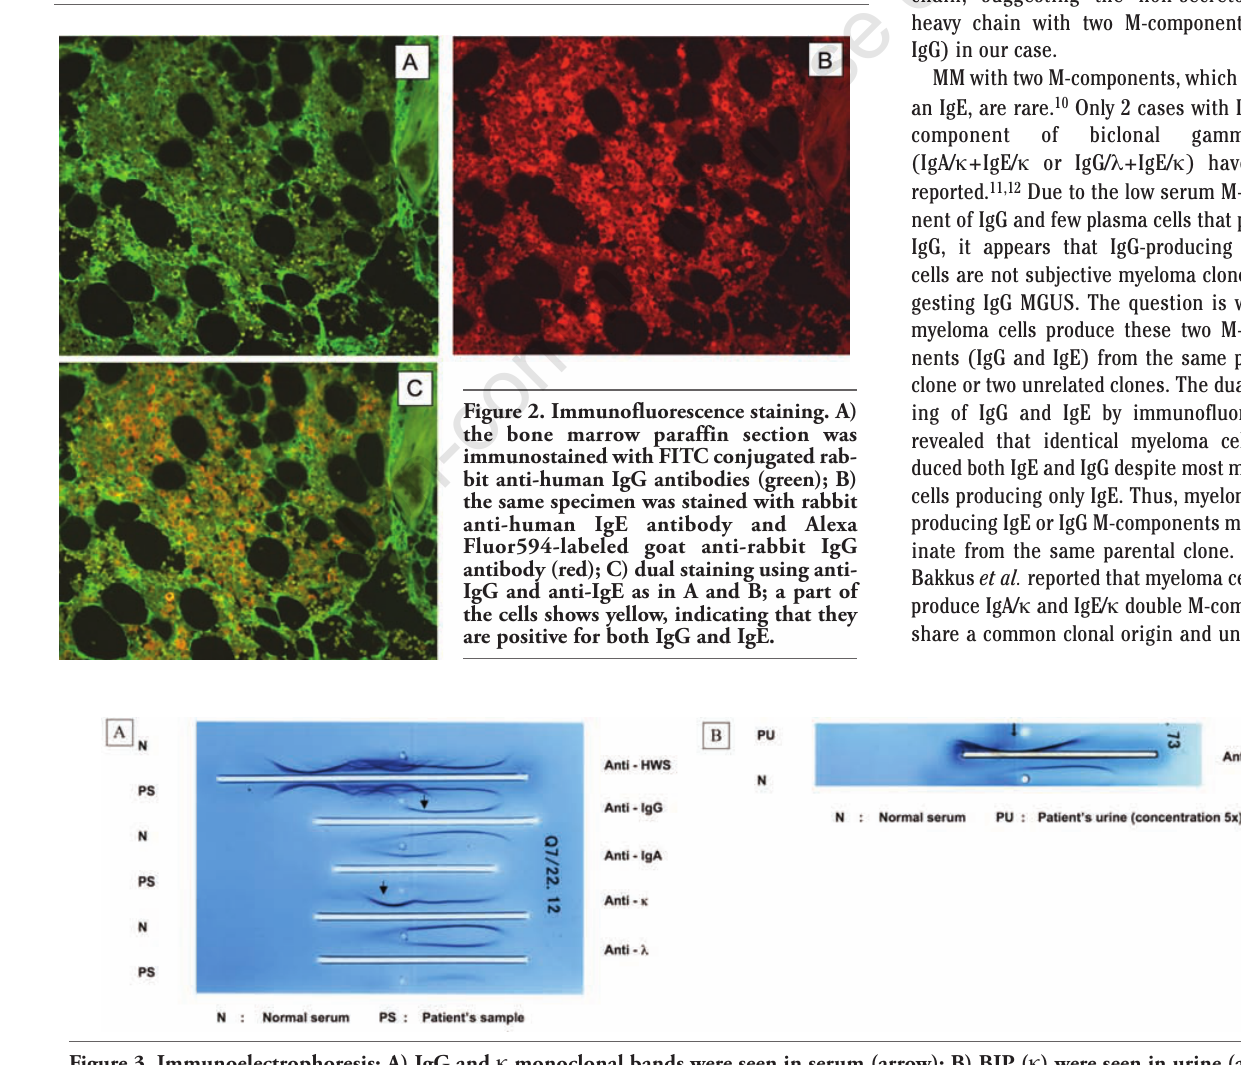
Figure 3. Immunoelectrophoresis: A) IgG and κ monoclonal bands were seen in serum (arrow); B) BJP ( κ ) were seen in urine